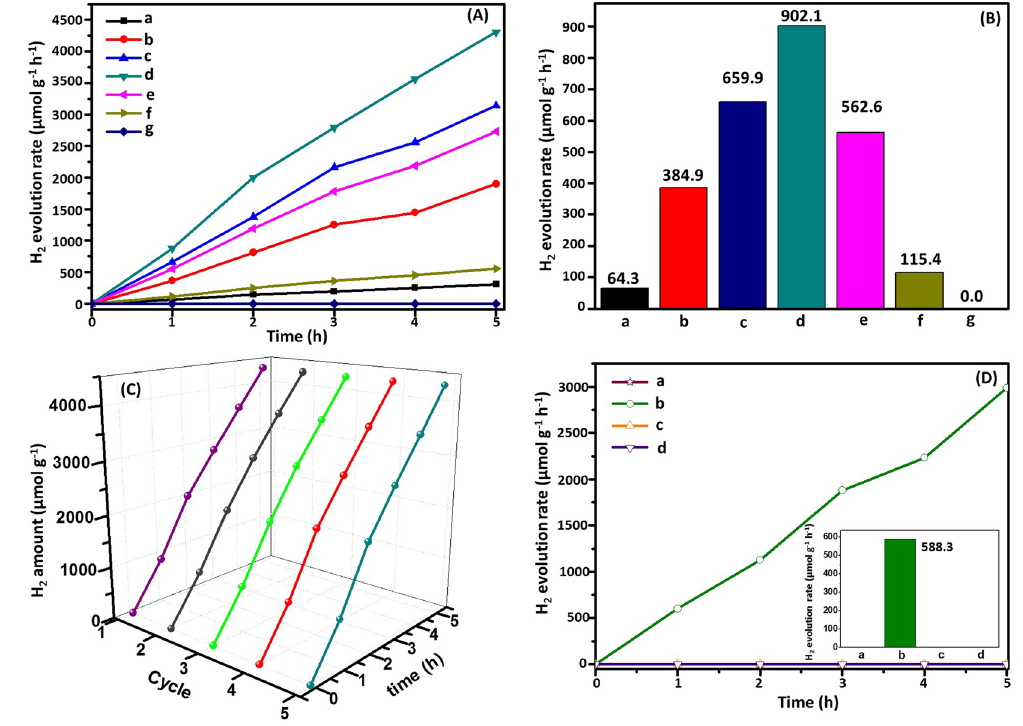
Figure 6. ( A ) Time courses of photocatalytic H 2 ( B ) the average rate of H 2 of (a) g-C 3 N 4 , (b) g-C 3 N 4 / Ag 2 CrO 4 (9.1%), (c) g-C 3 N 4 /Ag 2 CrO 4 (16.7%), (d) g-C 3 N 4 /Ag 2 CrO 4 (23.1%), (e) g-C 3 N 4 /Ag 2 CrO 4 (28.6%), (f) g-C 3 N 4 /Ag 2 CrO 4 (33.3%) and (g) Ag 2 CrO 4 under visible light irradiation; ( C ) Recyclability of the g-C 3 N 4 / Ag 2 CrO 4 (23.1%) in five successive experiments for the H 2 evolution under visible light irradiation; ( D ) Time courses of photocatalytic H 2 (insert: the average rate of H 2 ) of (a) g-C 3 N 4 with methanol without Pt, (b) g-C 3 N 4 /Ag 2 CrO 4 (23.1%) with methanol without Pt, (c) g-C 3 N 4 without methanol with Pt, and (d) g-C 3 N 4 / Ag 2 CrO 4 (23.1%) without methanol with Pt.